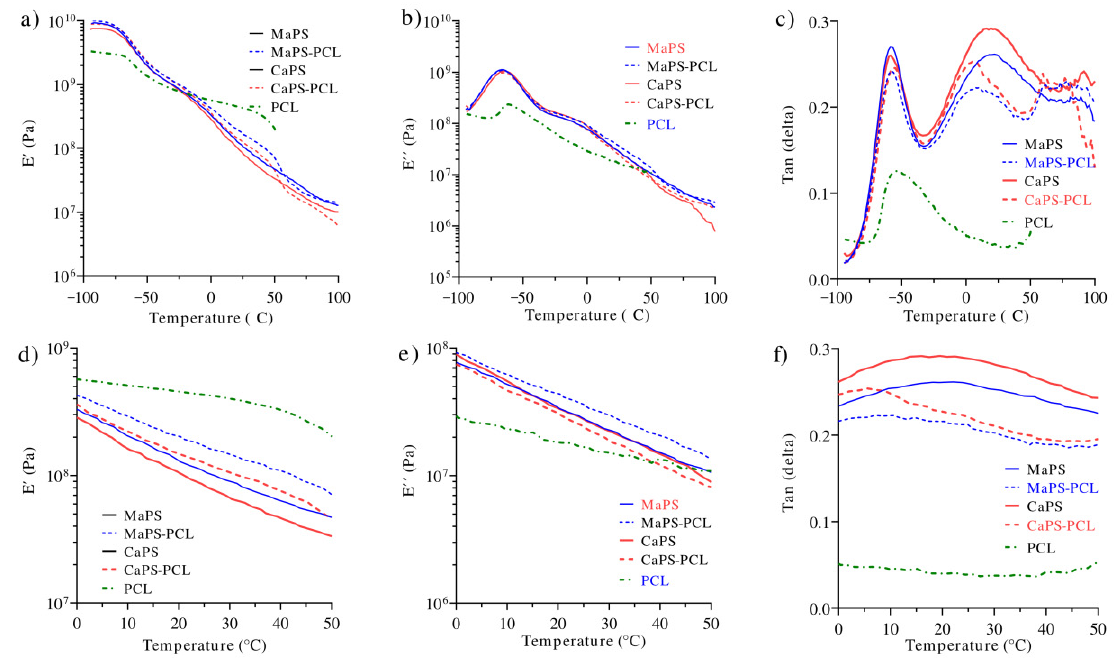
Figure 6. Loss factor (Tan delta) of the blends as a function of temperature.